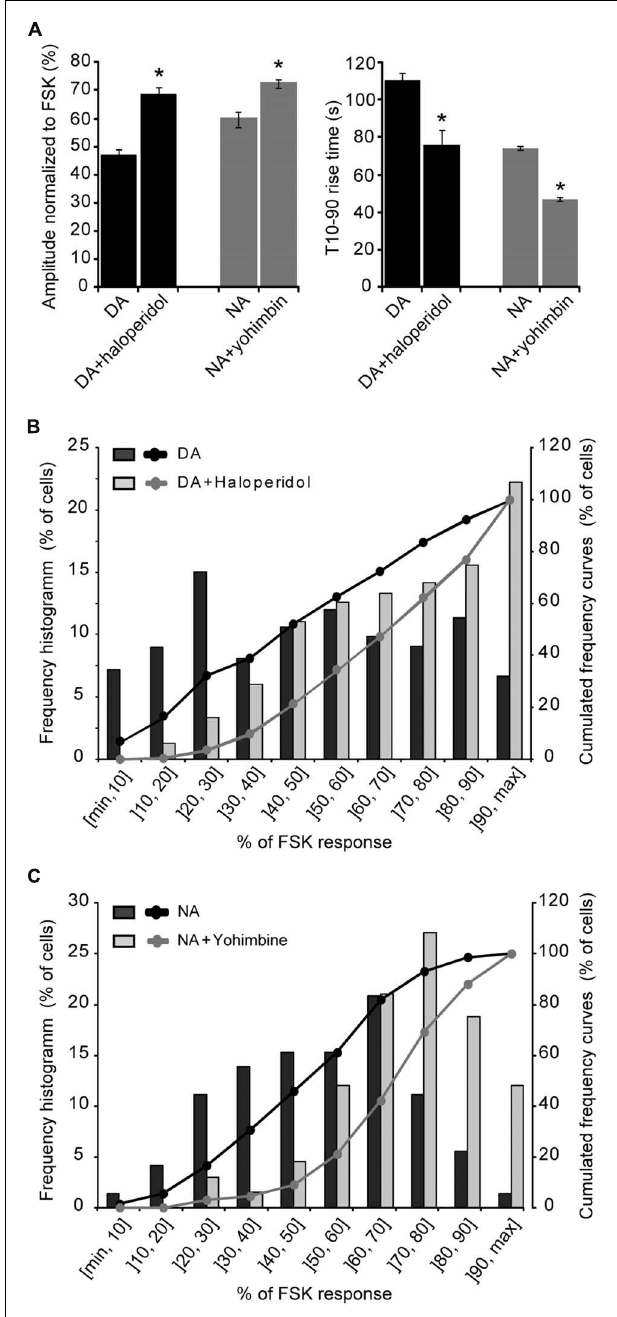
FIGURE 6 | Gi-coupled receptors dampen NA- and DA-induced PKA activation. (A) Mean amplitude and rise time of NA- and DA-induced (10 μ M each) PKA activation measured on layer II/III pyramidal neurons of the parietal cortex in the absence or presence of the D2-like antagonist haloperidol (1 μ M) or the alpha2 adrenergic antagonist yohimbin (1 μ M). (B,C) Distribution of FSK-normalized DA or NA response amplitudes measured in the same sample of neurons as in (A) in absence or presence of haloperidol or yohimbin.The left axis corresponds to the histogram of the proportion of cells for each amplitude interval and the right axis to the curve of cumulated frequency over the amplitude intervals. Note the shift of NA and DA response amplitude distributions toward higher amplitudes in the presence of antagonists of Gi-coupled